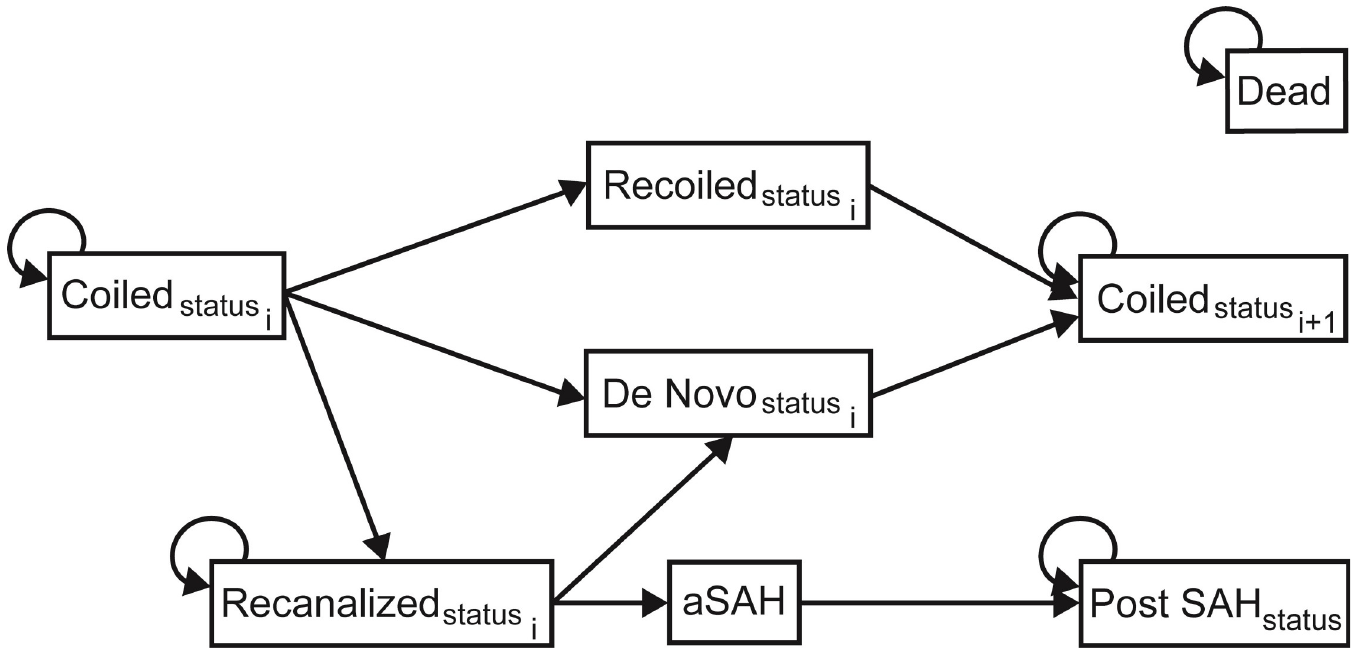
Fig 1. Markov model diagram illustrating all health states and possible transitions. All states may transition to Dead , however, these arrows have been left out for visual simplicity. Abbreviations: SAH–subarachnoid hemorrhage; aSAH–aneurysmal subarachnoid hemorrhage; mRS–modified Rankin Score; status –can be good function (mRS = 0), mild disability (mRS = 1–2), or moderate to severe disability (mRS = 3–5); i –can be 1 to 4 and represents the total number of coiling procedures a patient has had at any given time.